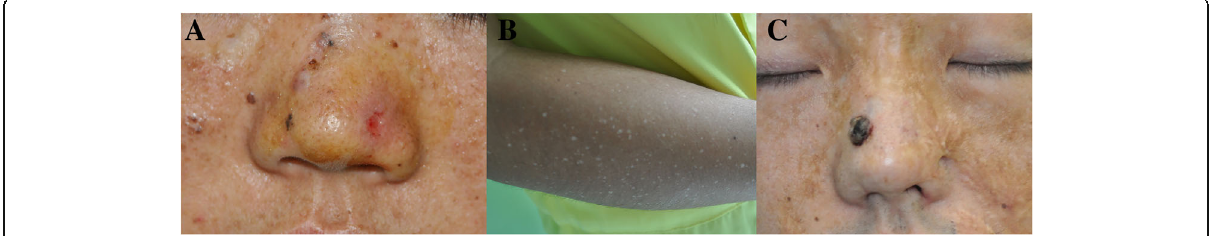
Fig. 1 Clinical findings of the proband and her brother. a . Freckle-like hyperpigmented macules on her face with an ulcerated bleeding nodule on her nose. b . Hyper- and hypopigmented macules on her arm. c . The proband ’ s brother has similar clinical